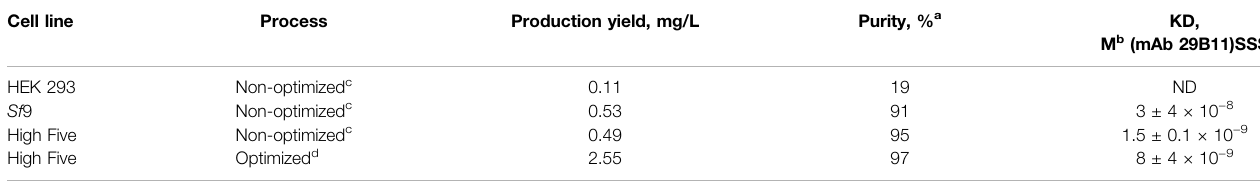
TABLE 1 | Summary of the production runs at 2 L STB